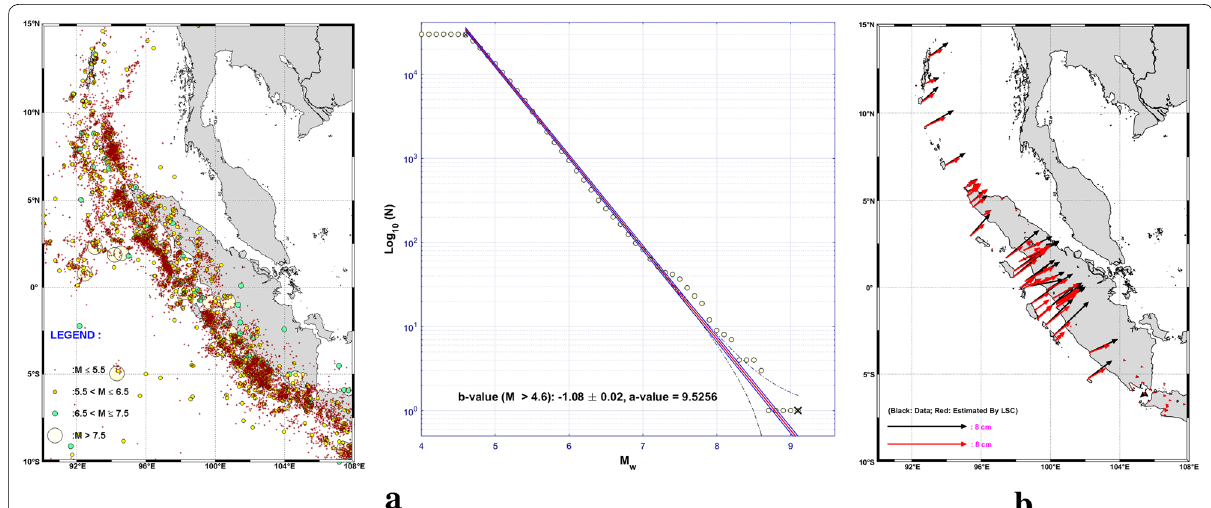
Fig. 1 Plot of the 2017 PuSGeN earthquake catalog data with hypocenter 50 km, M w 4.6 during the years 1963 to 2016, and the b -value ≤ ≥ estimation ( a ) and plot of GPS data mainly used for surface strain rate estimation ( b ). The GPS data from around the Sumatra Islands mainly were taken from Bradley et al. (2017), Chlieh et al. (2007) and Prawirodirdjo et al. (2010), Shearer and Burgmann (2010). In the case of the Andaman and Nicobar Islands, the pre-seismic velocity crustal movement model resulted on the basis of forward modeling (Okada 1985, 1992) by referring to the co-seismic data of Subarya et al. (2006), Chlieh et al. (2007) in which the plate convergence rate of 14 mm/year (Bilham et al. 2005) is